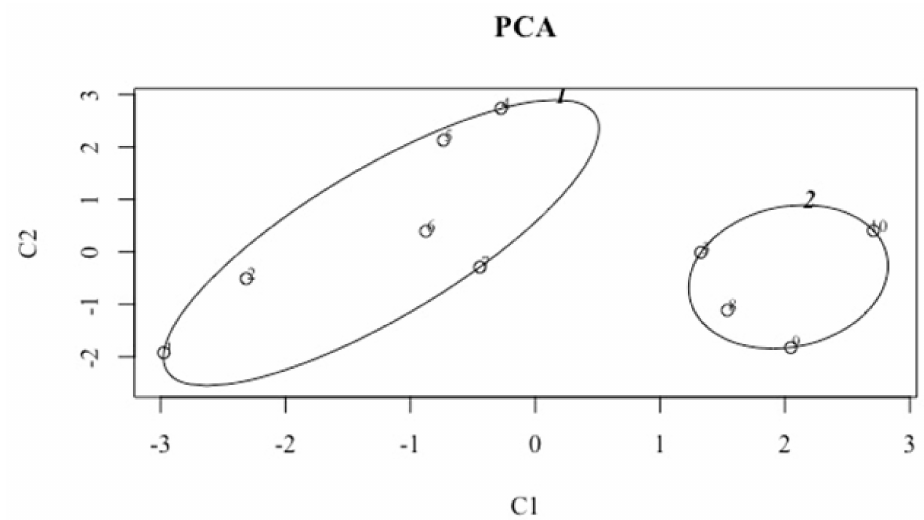
Figure 2. Principal Component Analysis with concentration and confidence ellipses around each group, including the six performance measures. Each main component is obtained by linear combination of the original six variables, and every dot inside the ellipses represents one individual in the HI ( n = 6) and LO ( n = 4) groups. These two components explain 74.72% of the point variability.